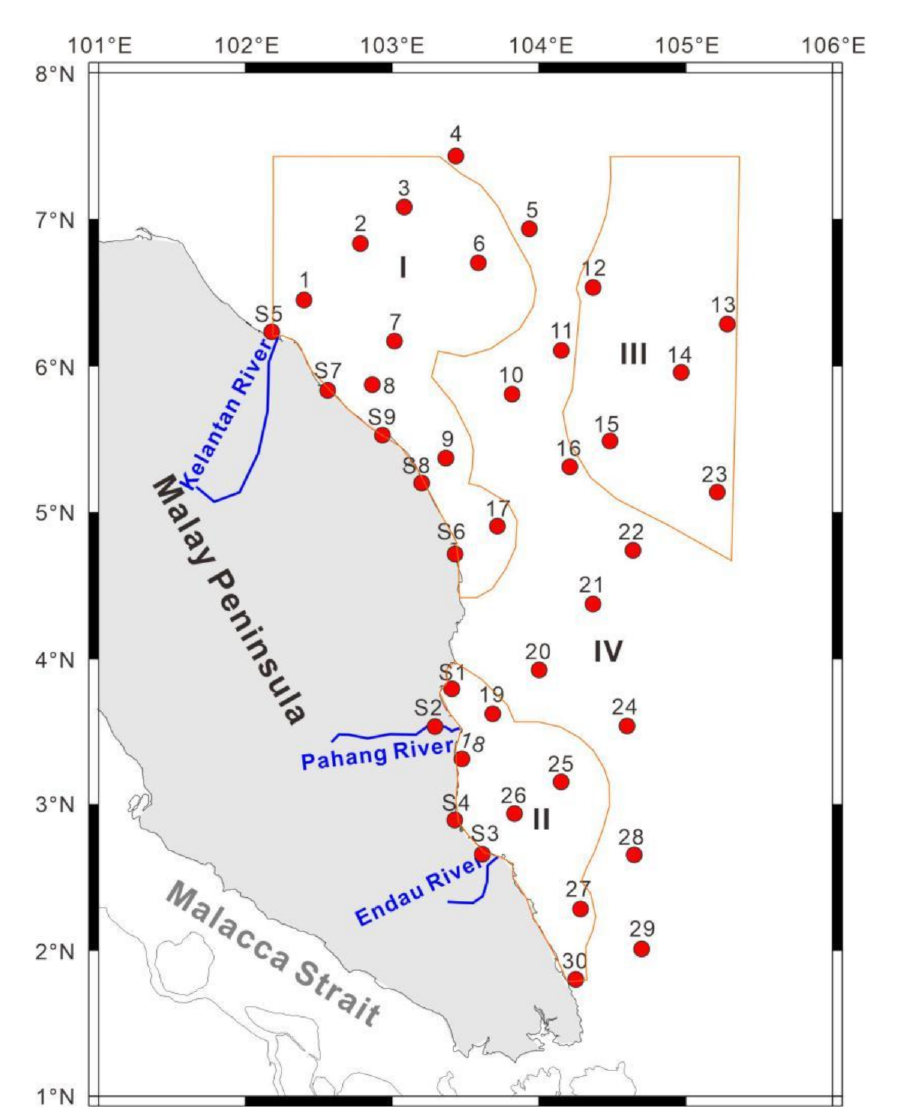
Figure 6. Divisions of the various sediment sources (Provinces I–IV) on the southwestern Sunda Shelf near the Malay Peninsula. Orange lines represent the estimated boundaries of the combined geochemical and mineral provinces in the study